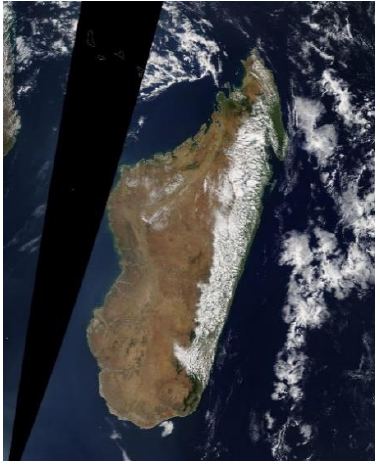
Figure 2. Visible channel imagery of MODIS onboard Terra satellite for the 10 September 2016 over the Madagascar and surrounding